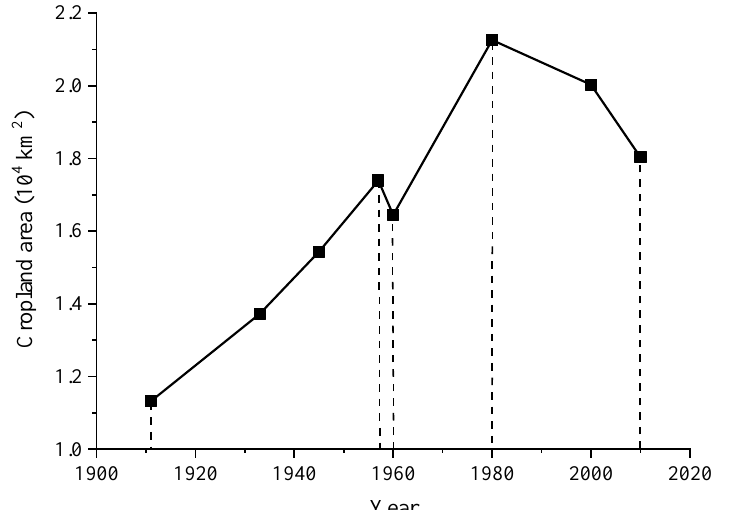
Figure 4. Variation in the reconciled cropland area in the Tuojiang River Basin from 1911 – 2010.